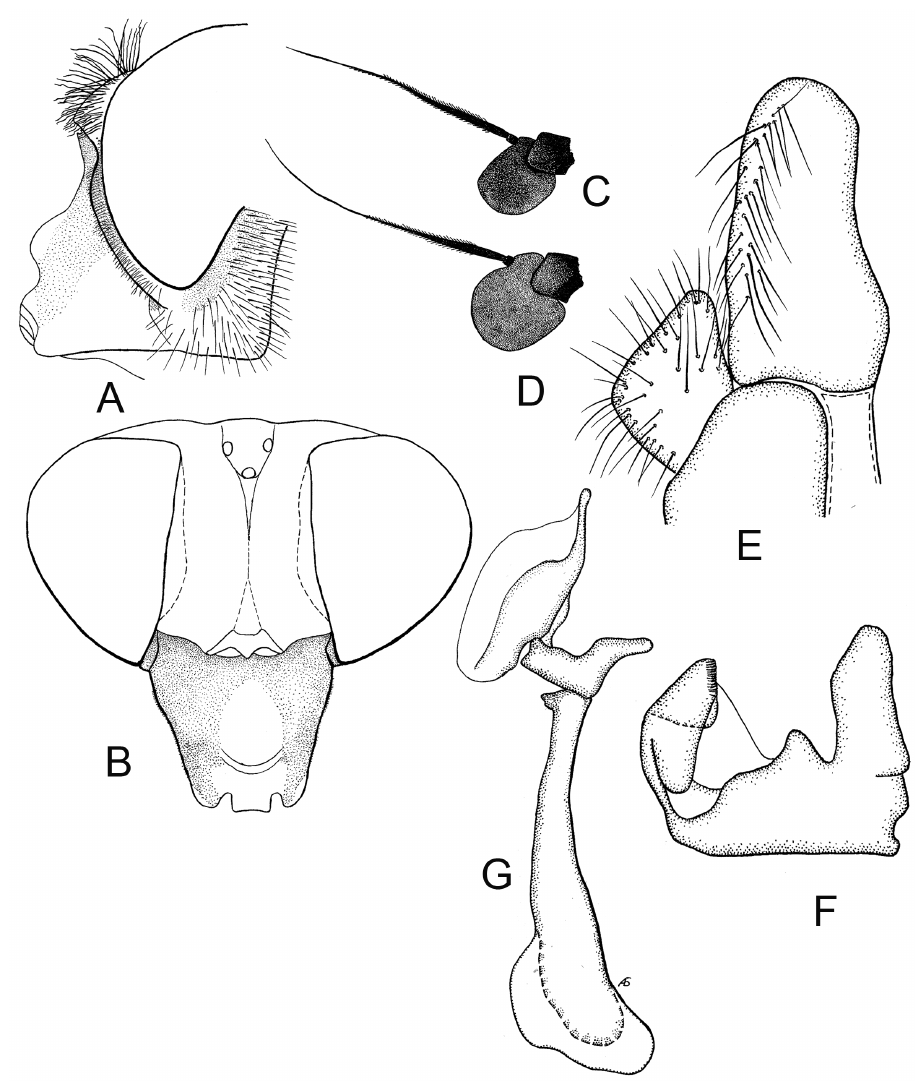
Figure 3. Cheilosia caerulescens caerulescens (Meigen). A Head of male, lateral view B Head of female dorsal view C Antenna of male, lateral view D Antenna of female, lateral view E–G male genitalia, lateral, from left to right: E Cercus+surstylus F Superior lobe G Aedeagal complex.